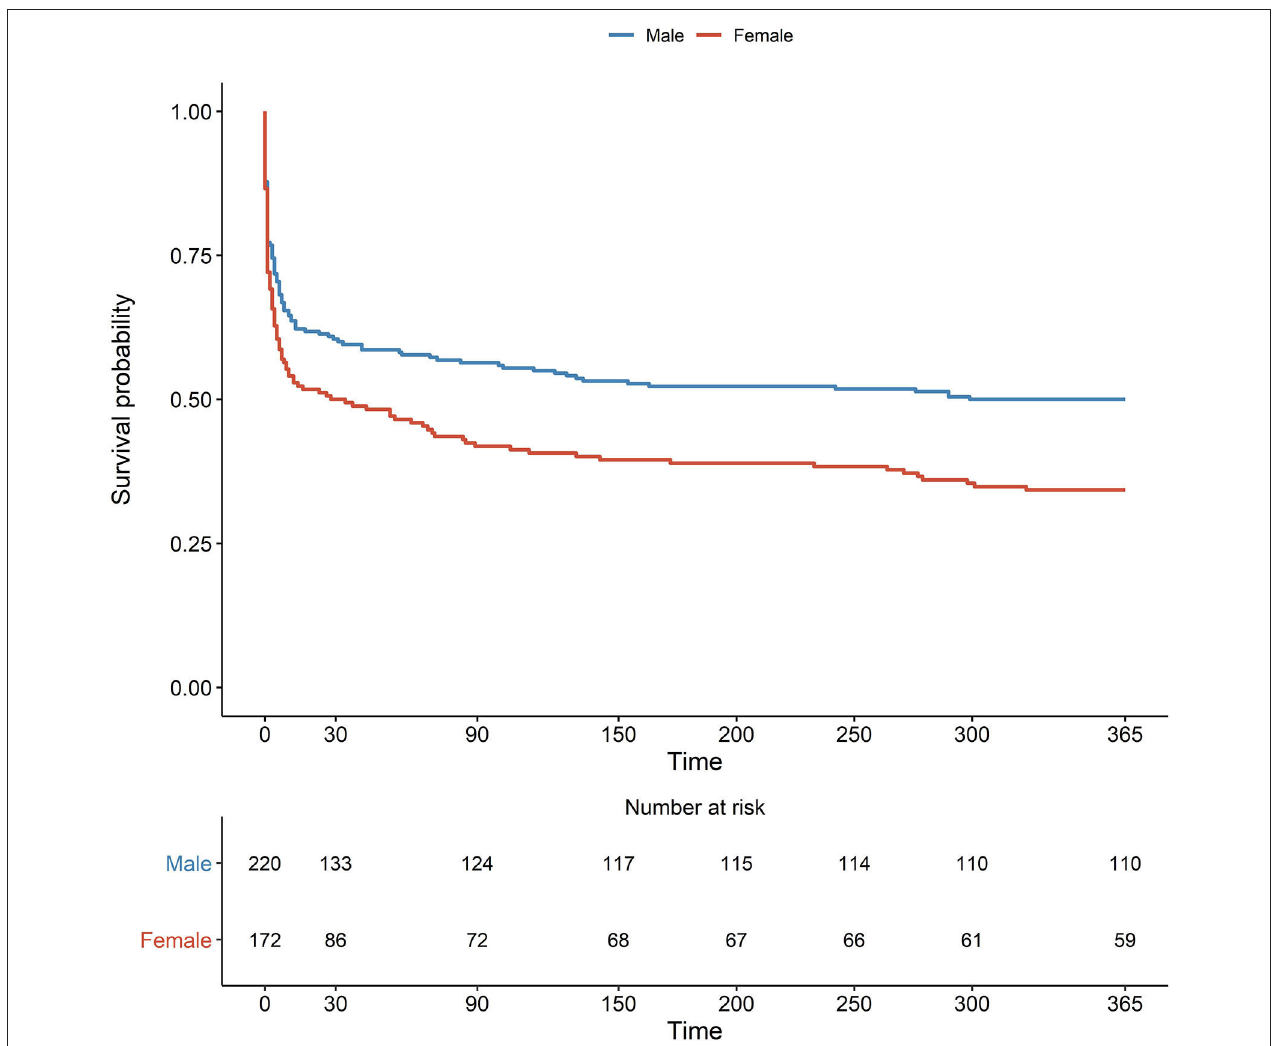
FIGURE 6 | Kaplan–Meier plot with numbers at risk and number of events.